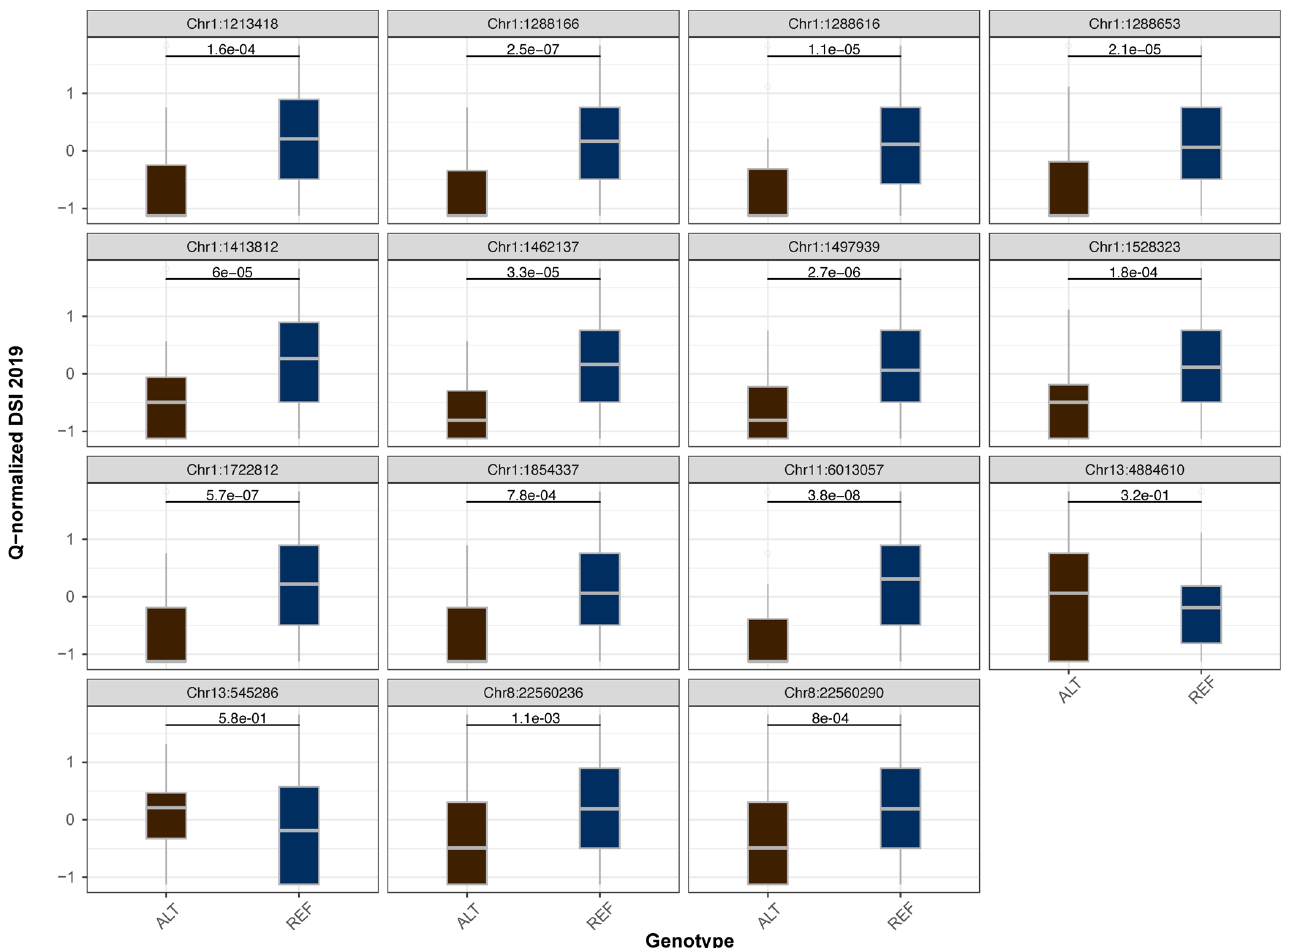
Figure 3. Box plots of the allelic effects observed in stable QTNs in 2019 year. Numbers are p -values according to the Mann–Whitney–Wilcoxon non-parametric test.